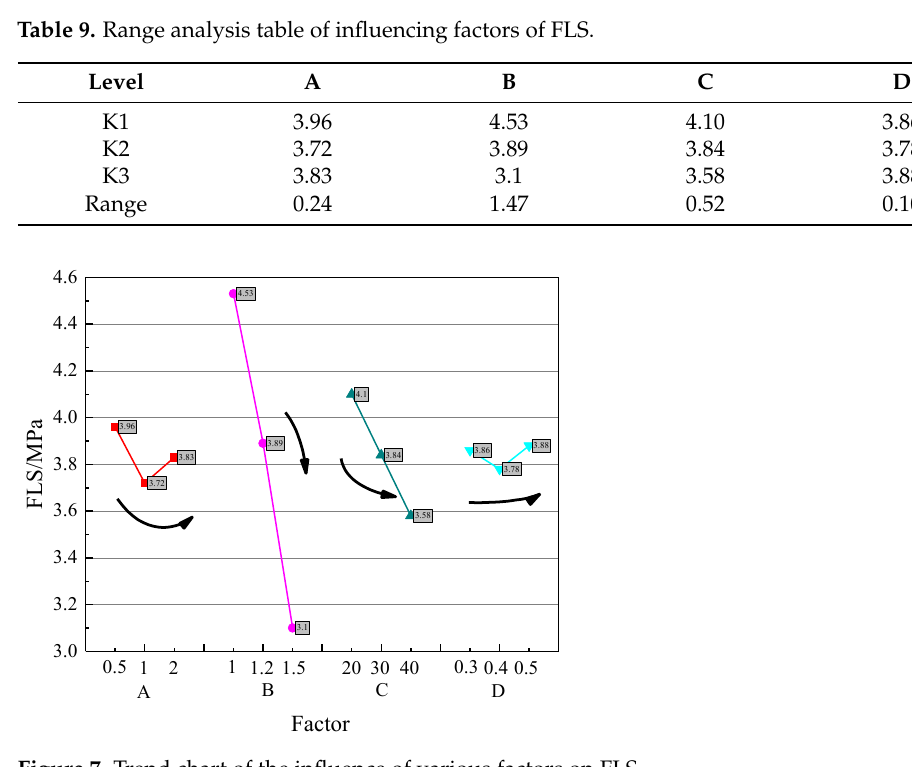
Table 9. Range analysis table of influencing factors of FLS.